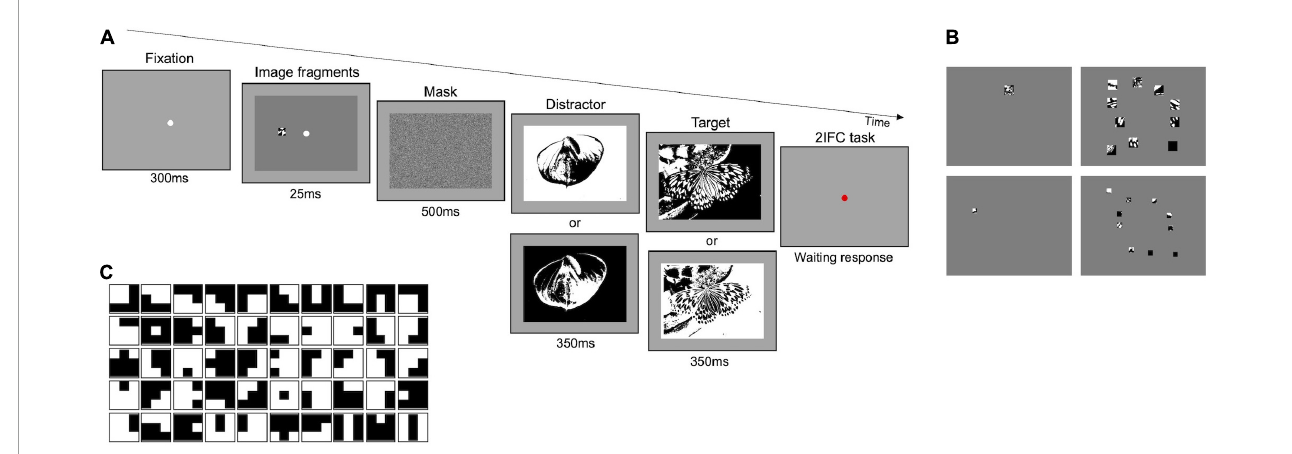
FIGURE2 Main experiment–Procedure and stimuli. (A) Representation of experimental paradigm. The example illustrated in the upper row shows a trial where the distractor is presented with inverted contrast and the target with its original. The two panels below target and distractor indicate that in some trials either one or both of them can have a contrast inverted with respect to those shown above. (B) Examples of stimuli. Fragments in the images of each column are the same number but their size decreases by 50 percent from top to bottom; fragments in the images of each row have the same size but vary in number (1 or 10). (C) Set of optimal features. Set of 50 3 × 3-pixels features extracted by applying the constrained maximum entropy model to black and white images (Del Viva et al., 2013).